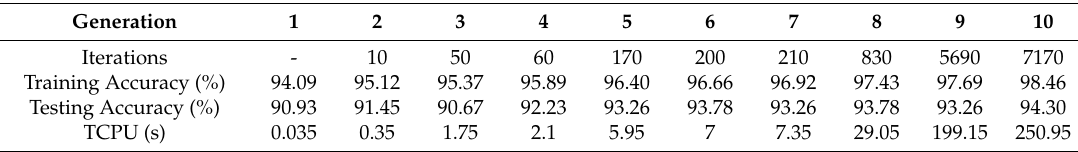
Table 2. Iterations for each generation of conditions